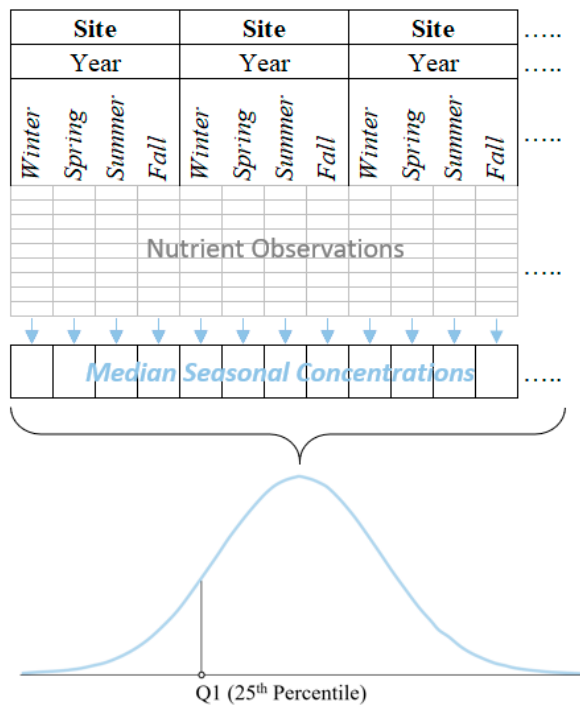
Figure 3. Percentile method proposed by the US Environmental Protection Agency for determining numeric water quality criteria in streams. The lower 25th percentile of all nutrient data is estimated to represent a basis for background water quality conditions that are considered good water quality without nutrient impairments. For each site, a median value for each season for each year from 2000 to 2019 was used as the final aggregate dataset for analysis and nutrient criteria comparisons.